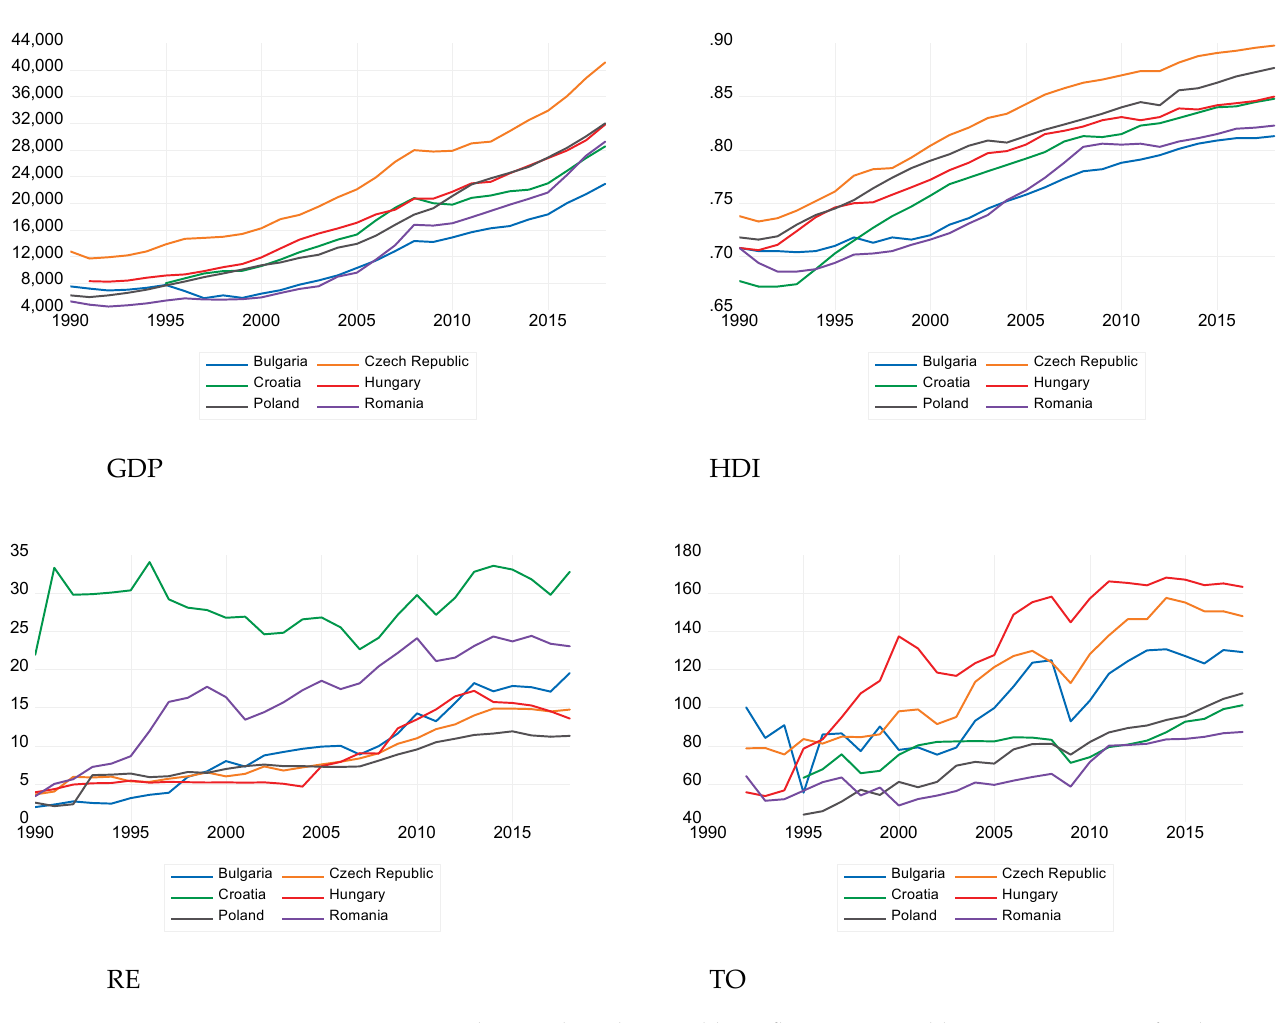
Figure 2. Trends regarding the variables reflecting renewable energy transition for the period 1990–2018. Source: Authors’ projection, using Eview.